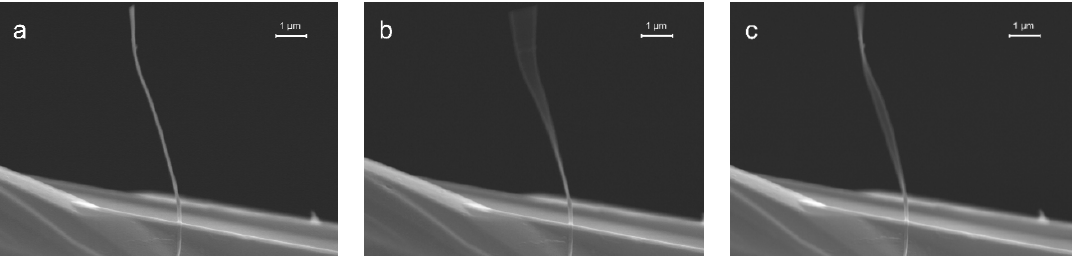
Figure 13. MWCNT ( a ) stationary and at ( b ) the first mode ( ν 1 = 0.750 MHz) and ( c ) the second mode ( ν 2 = 4.755 MHz). Applied piezo driving voltage of 10